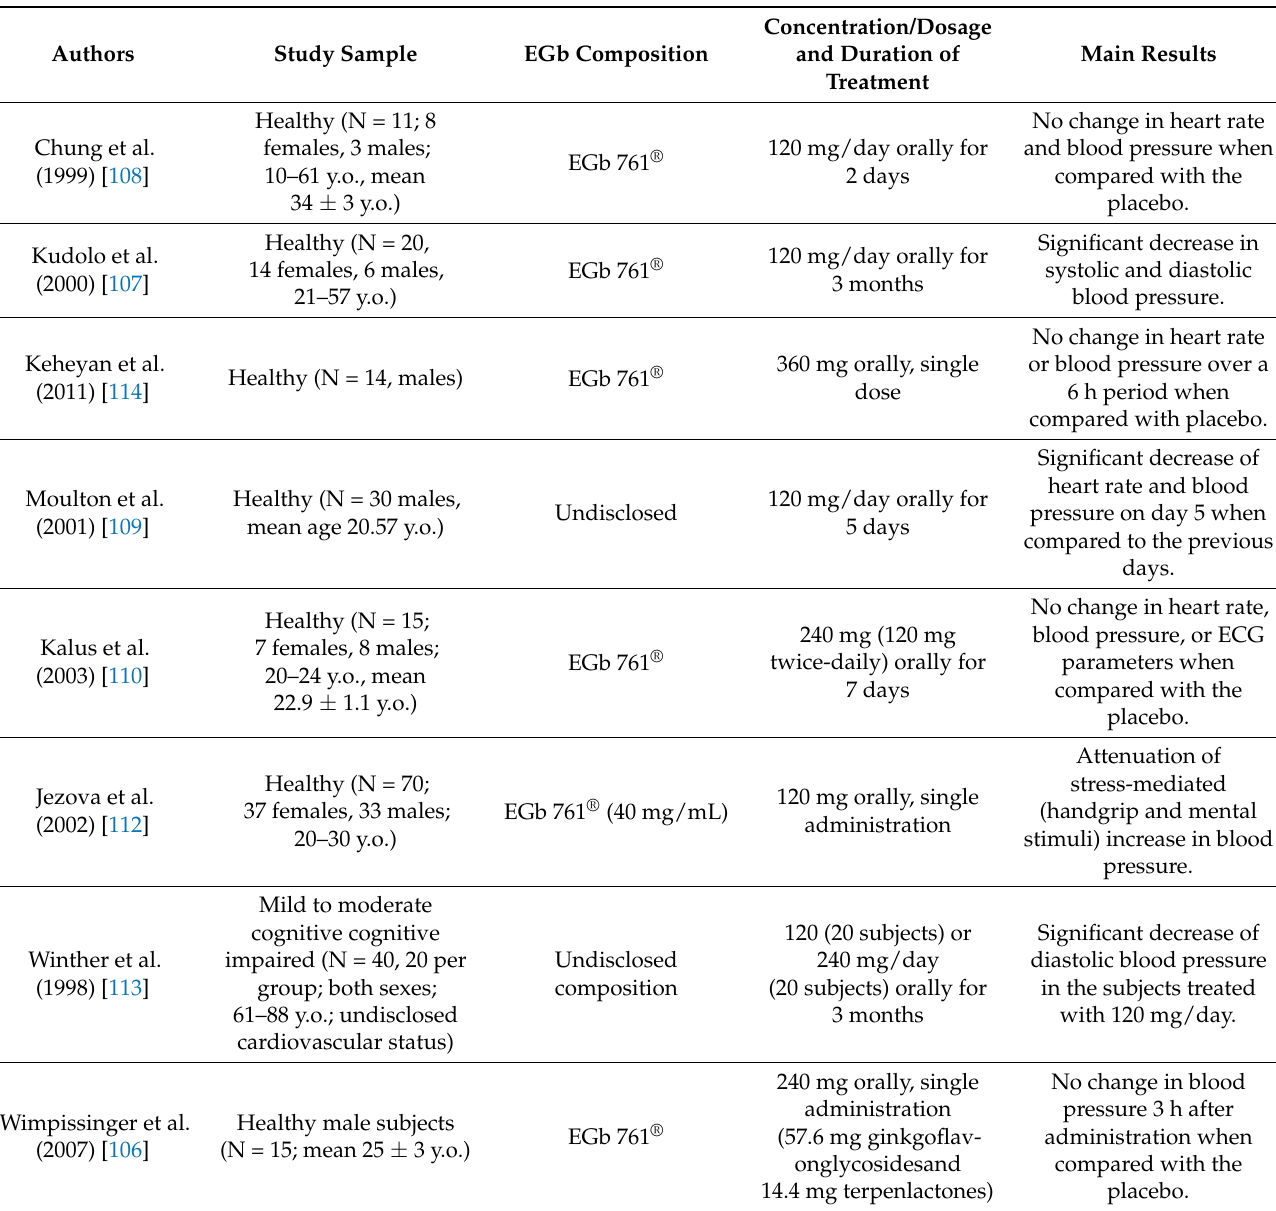
Table 4. Main results of the clinical studies on the effects of Ginkgo biloba on the blood pressure of healthy human subjects (EGb—extract of Ginkgo biloba; ECG—electrocardiography; y.o.—years